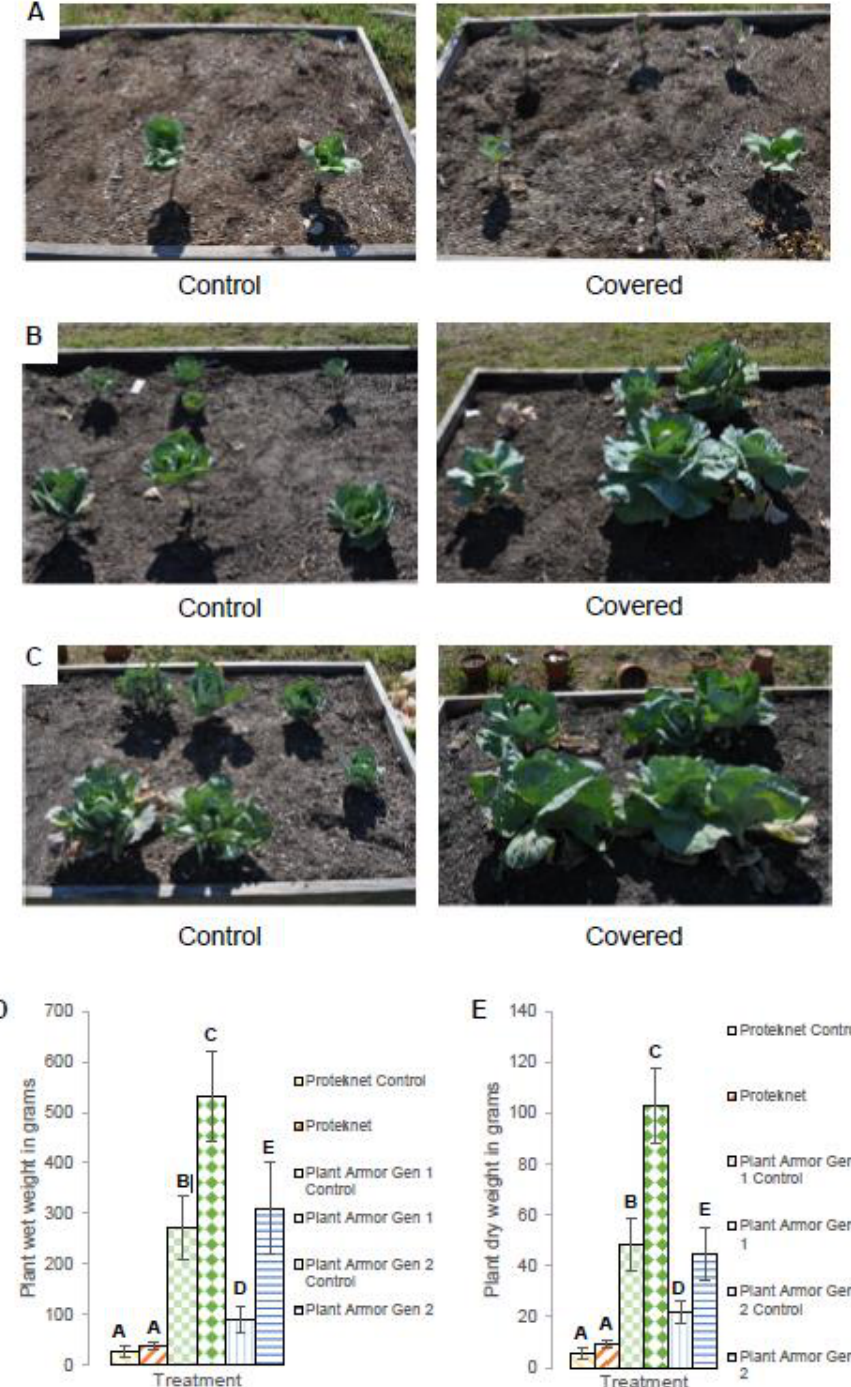
Figure 8. Cabbage at 90 days under ( A ) Proteknet, ( B ) Plant Armor Generation (Gen) 1 and ( C ) Plant Armor Gen 2; ( D ) plant wet weight; and ( E ) plant dry weight. The error bars are ±1 SEM. Treatments that were statistically significantly different, according to ANOVA and Tukey’s test, are indicated by different letters on the bar graph. There were no temperature (1200: F = 0.58, df = 2, p = 0.568; 2400: F = 0.20, df = 2, p = 0.979) and humidity (1200: F = 1.29, df = 2, p = 0.299; 2400: F = 0.40, df = 2, p = 0.679) differences outside versus under Proteknet, Plant Armor Gen 1, and Plant Armor Gen